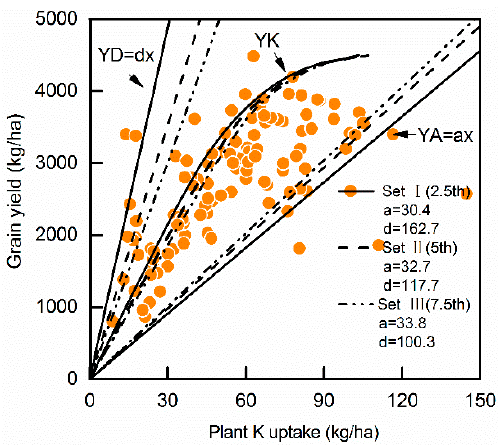
Figure 3. Balanced plant N, P, and K uptake requirement at three sets of a and d simulated by the QUEFTS model. YA and YD represent the boundary lines of the relationship between yield and uptake. YN, YP, and YK represent the balanced N, P, and K uptake curve.